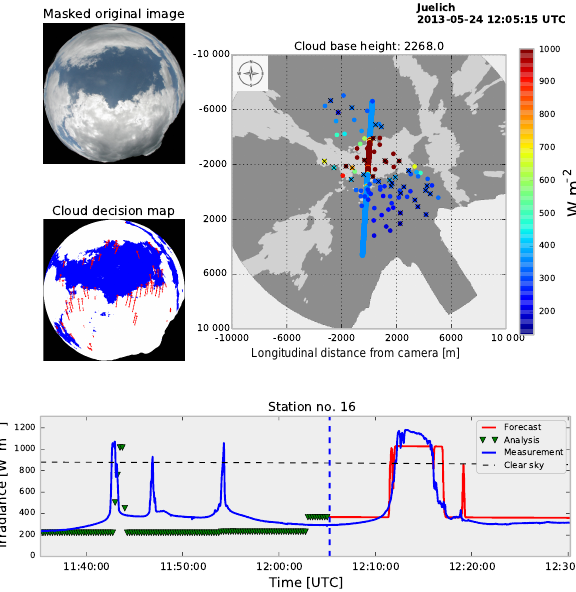
Figure 6. Forecast example. Upper left: masked raw image. Cen- tre left: binary cloud decision map with CMVs over the last 60s. Right: shadow map on the regular 20km × 20km grid. Pyranome- ter stations and measurements are given in coloured dots. Stations with a black cross were flagged as invalid for that time and not used for the analysis. The forecast path along the mean cloud direction for one station is drawn as a thick line. Bottom: corresponding time